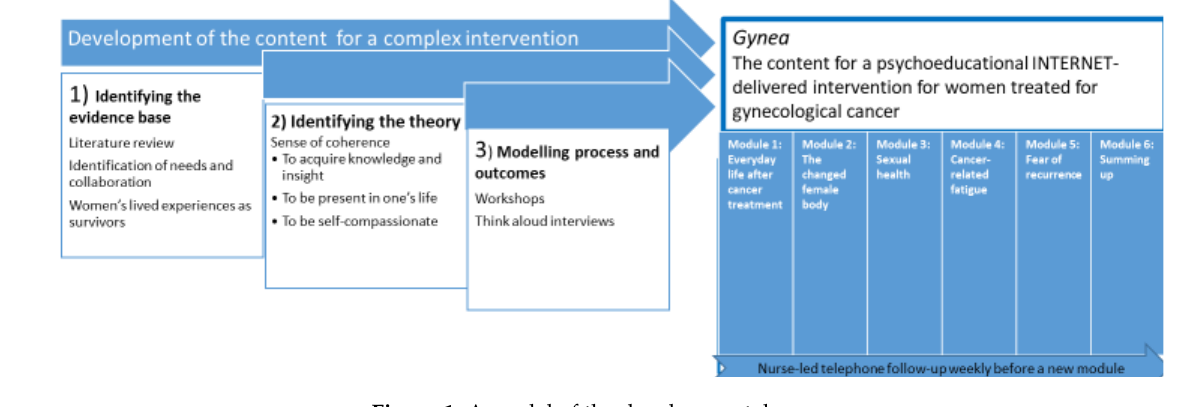
Figure 1. A model of the developmental process.